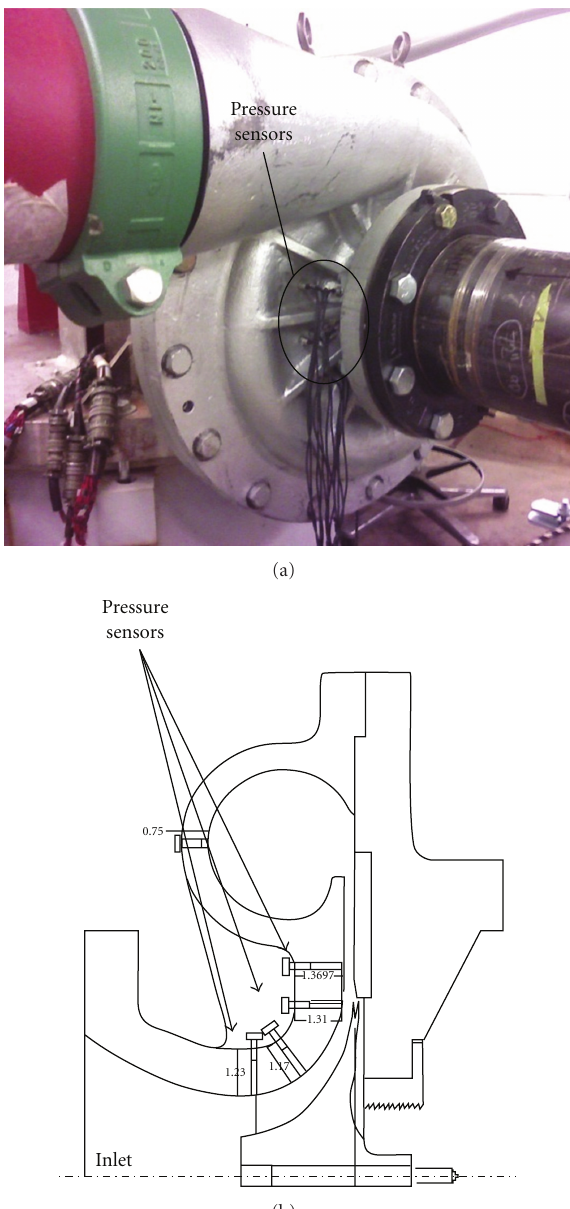
Figure 6: Twelve pressures sensors, divided into three lines of four, installed on the compressor front casing. Relative locations are shown in Figure